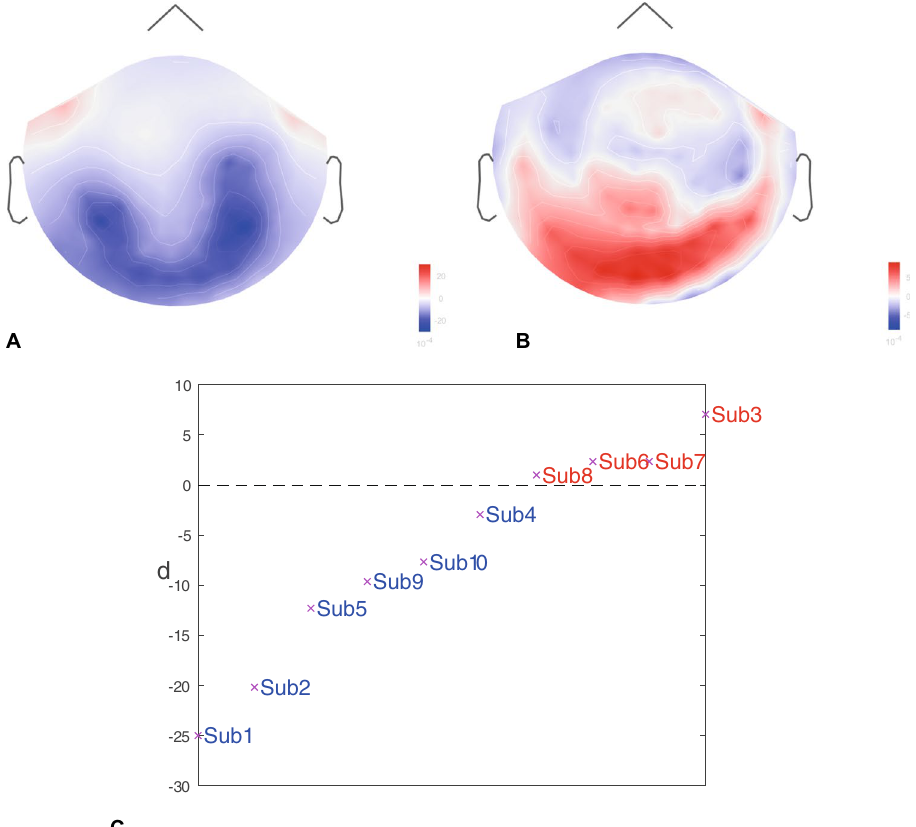
Figure 3. Typical results of event-related synchronizaiton/desynchronization (ERS/ERD) averaged over all trials for KI and VI. ( A ) Event-related desynchronization (ERD) in μ -band for KI subject 1. ( B ) Event-related synchronization (ERS) in μ -band for VI subject 7. ( C ) Averaged over all channels ERS/ERD degree d of all subjects. The subjects are classified into KI and VI groups depending on the sign of d , i.e., the subjects with d < 0 belong to the KI group, while the subjects with d > 0 to the VI